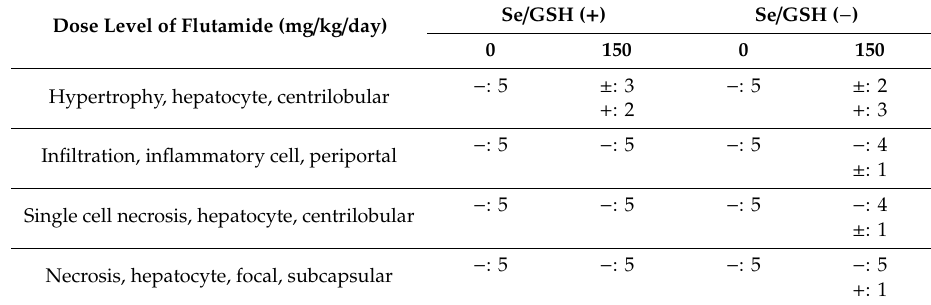
Table 2. The histopathological findings of the liver in the Se / GSH ( + ) and ( − ) rats treated with